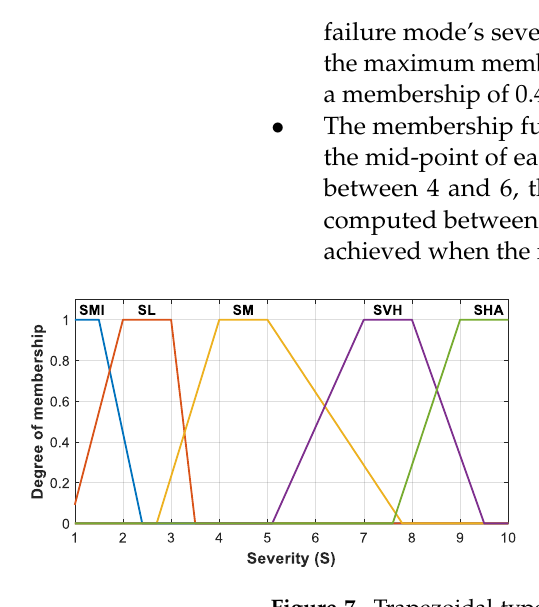
Figure 7. Trapezoidal type-I FIS membership functions for the FMECA risk factors Severity and FuzzyRPN .